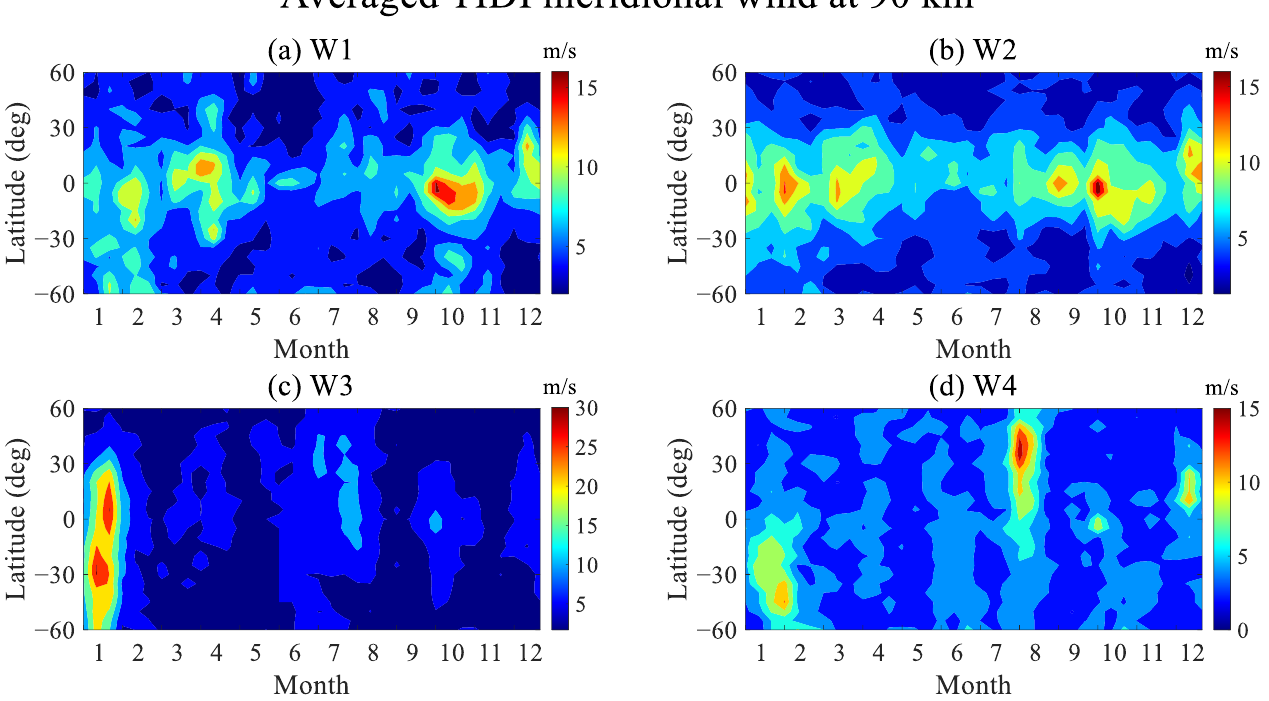
Figure 5. The averaged TIDI ( a ) W1, ( b ) W2, ( c ) W3 and ( d ) W4 meridional wind at 90 km at latitudes of 60 ° S to 60 ° N from 2003 to 2012.